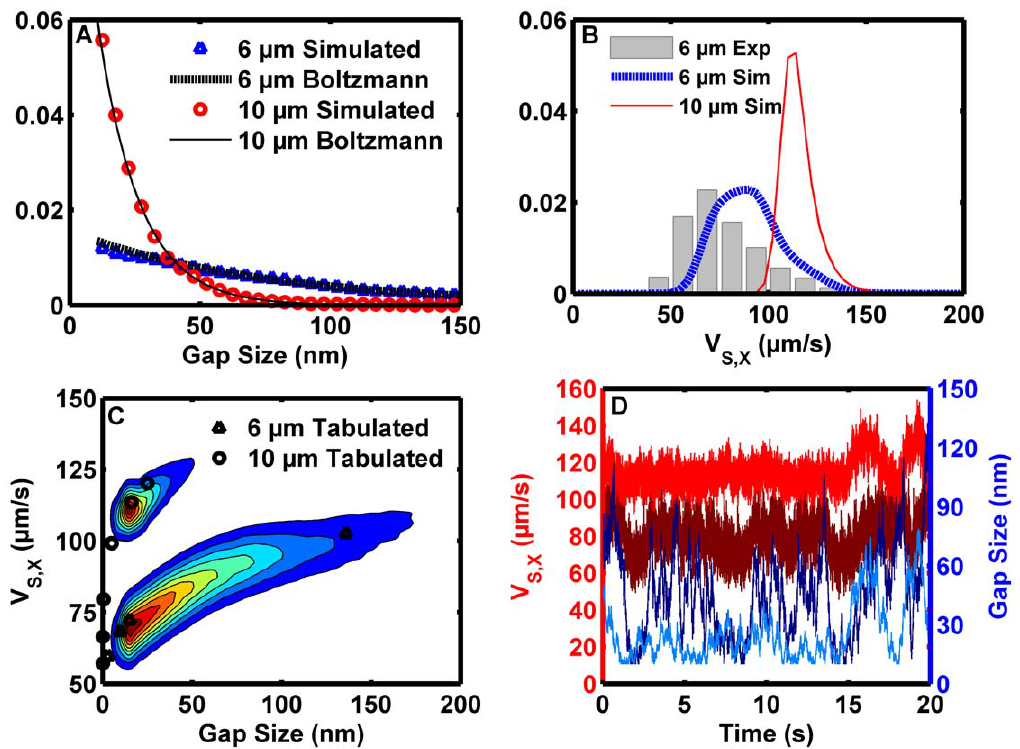
Figure 3. Investigation of non-reactive microsphere motion with a 50 s 2 1 wall shear rate. (A) The probability distribution functions for gap size for a simulated 6 m m-diameter sphere (blue triangles), the theoretical Boltzmann distribution for a 6 m m-diameter sphere (heavy dashed line), a simulated 10 m m-diameter sphere (red circles), and the theoretical Boltzmann distribution for a 10 m m-diameter sphere (narrow solid line) are shown. The simulation results agree well with the equilibrium theory and demonstrate vertical diffusion occurs over a biochemically relevant length. (B) Sampled instantaneous, flow-direction velocity probability distribution functions for a 6 m m-diameter sphere (heavy blue dashed line) and a 10 m m-diameter sphere (narrow red line) are shown and compared to the experimental results with microbeads possessing a nominal diameter of 6 m m [39] (grey bars). The results demonstrate the experimentally observed skewing of the instantaneous velocity distribution from normal and predict a tighter velocity distribution for larger particles. (C) Contour plots of the probability distribution functions of the sampled instantaneous, flow-direction velocity for a simulated 6 m m sphere (bottom) and a 10 m m simulated sphere (top) at 50 s 2 1 are shown. Each was re-normalized to the respective maximum, so the results for the 6 m m-diameter sphere cover a larger area. Tabulated deterministic solutions published by Goldman et al. [40] are shown as triangles (6 m m-diameter sphere) and circles (10 m m-diameter sphere). Although agreement was good, the simulation slightly underpredicted the superposition result. (D) Time-domain flow-directed instantaneous velocity for a 6 m m-diameter sphere (maroon line), flow- directed instantaneous velocity for a 10 m m-diameter sphere (red line), gap size for a 6 m m-diameter sphere (dark blue line), and gap size for a 10 m m- diameter sphere (light blue line) are shown. The low-frequency fluctuations in the instantaneous velocity reflected fluctuations in the